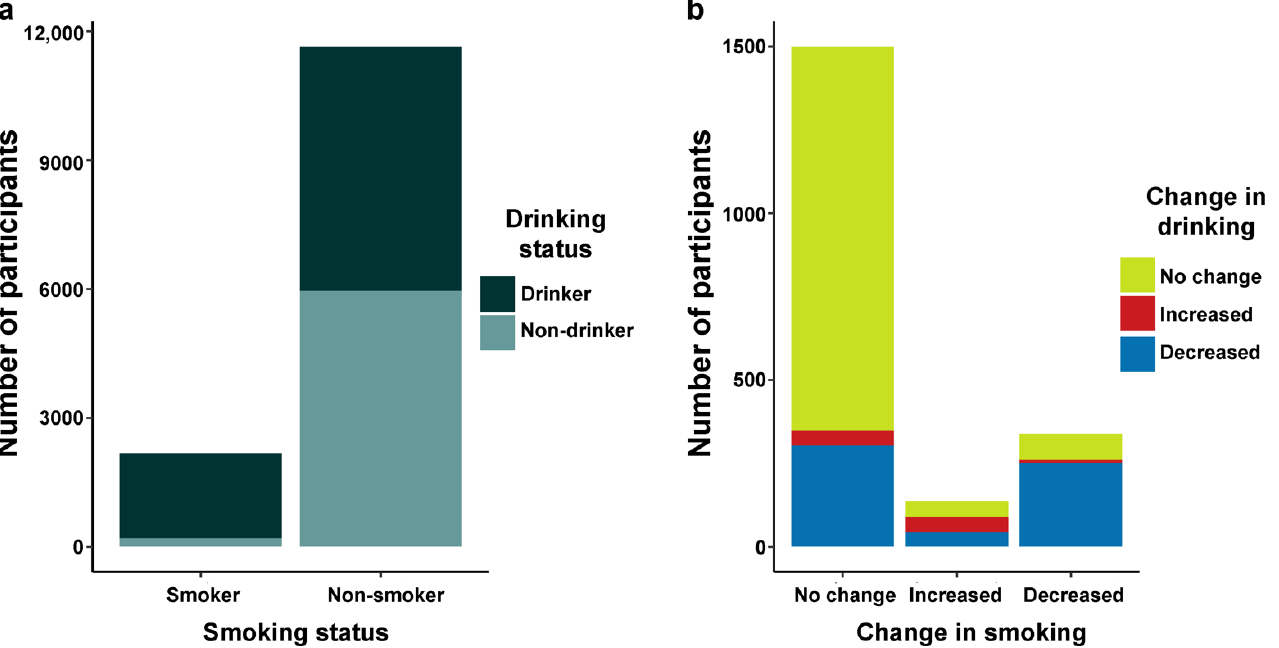
Figure 1. Bivariate relationships between ( a ) smoking status vs. drinking status and ( b ) change in smoking vs. change in drinking.